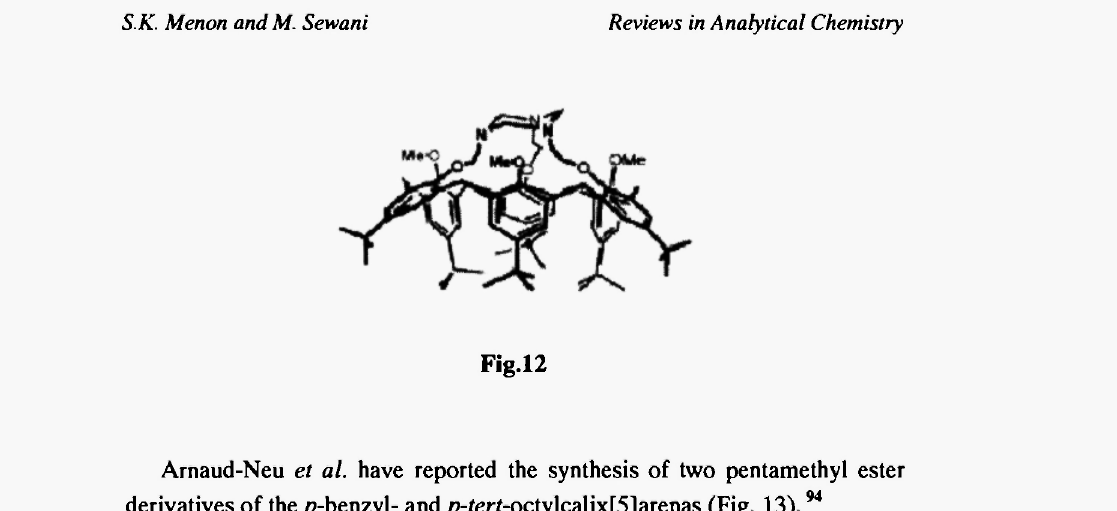
Arnaud-Neu et al. have reported the synthesis of two pentamethyl ester derivatives of the p-benzyl- and p-ieri-octylcalix[5]arenas (Fig. 13).